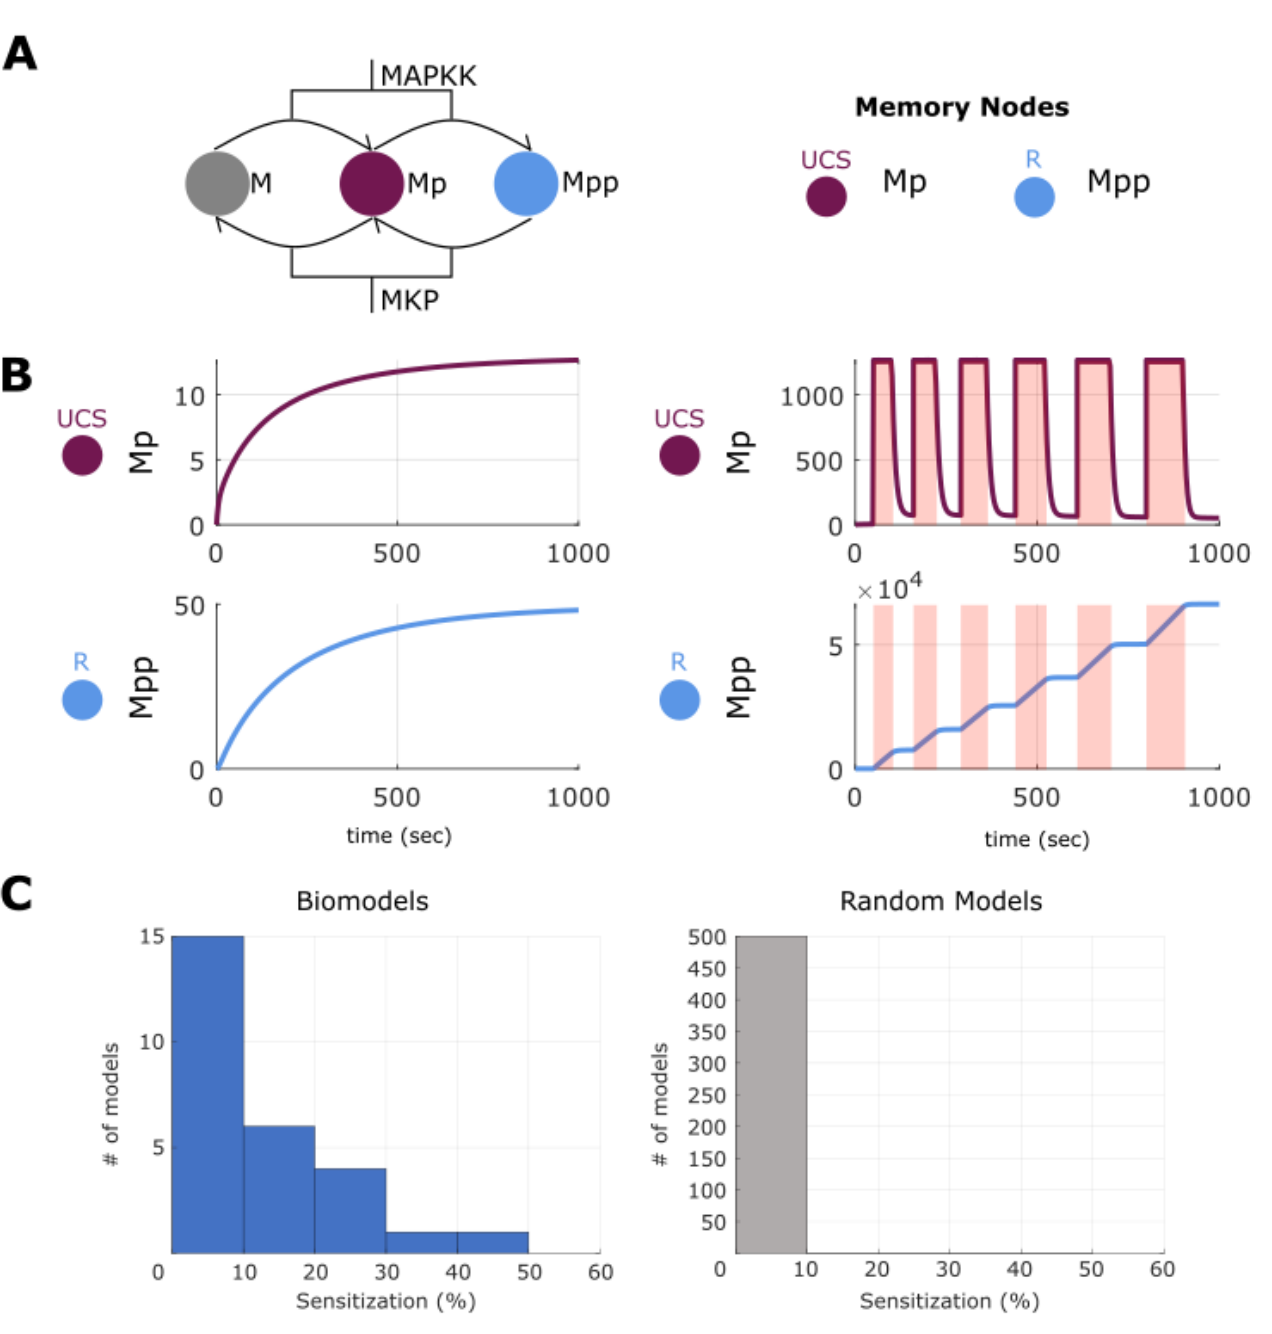
Figure 10. Sensitization in biological models. ( A ) An example of sensitization in a potential memory model built from [75] that passed the pretest. ( B ) On the left, the effects of a single stimulation—an upregulation of the UCS results in an upregulation of R. On the right, an example of sensitization. Progressive stimulation (upregulation, red shaded area) of UCS results in less and less response from R (upregulation to upregulation). ( C ) Distribution of pharmacoresistance across all biological models and random networks. The x axis is measured as the percentage of memory models for a given biological model that show sensitization. We performed a Wilcoxon rank sum test applicable to un-equal samples to test the similarity of the distributions and they are significantly different ( p = 5.13 × 10 − 70 ).